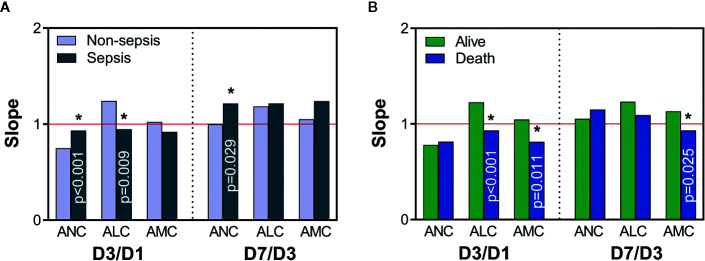
The time-varying slope of immune-cell counts. Comparisons of slopes between non-sepsis and sepsis groups (A), and alive and death groups (B). A value of slope >1 (red line) indicates an upward trend in immune-cell counts, and a value <1 indicates a downward trend; *Represents a significant difference between non-sepsis and sepsis groups or alive and death groups. ANC, absolute neutrophil count; ALC, absolute lymphocyte count; AMC, absolute monocyte count; D1, day-1; D3, day-3; D7, day-7.